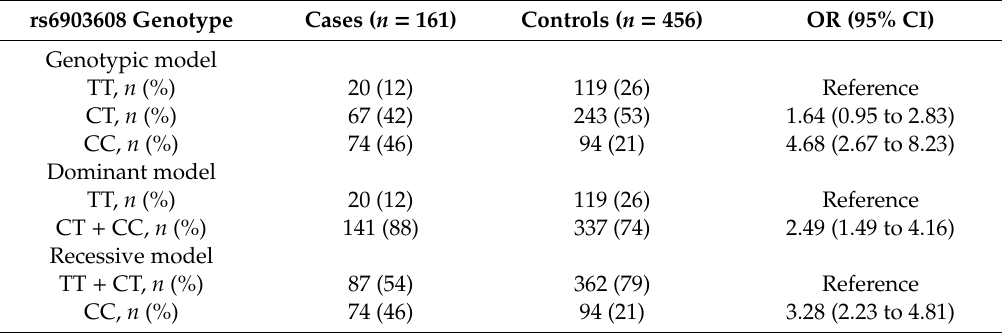
Table 2. Risk of a first iTTP episode by rs6903608